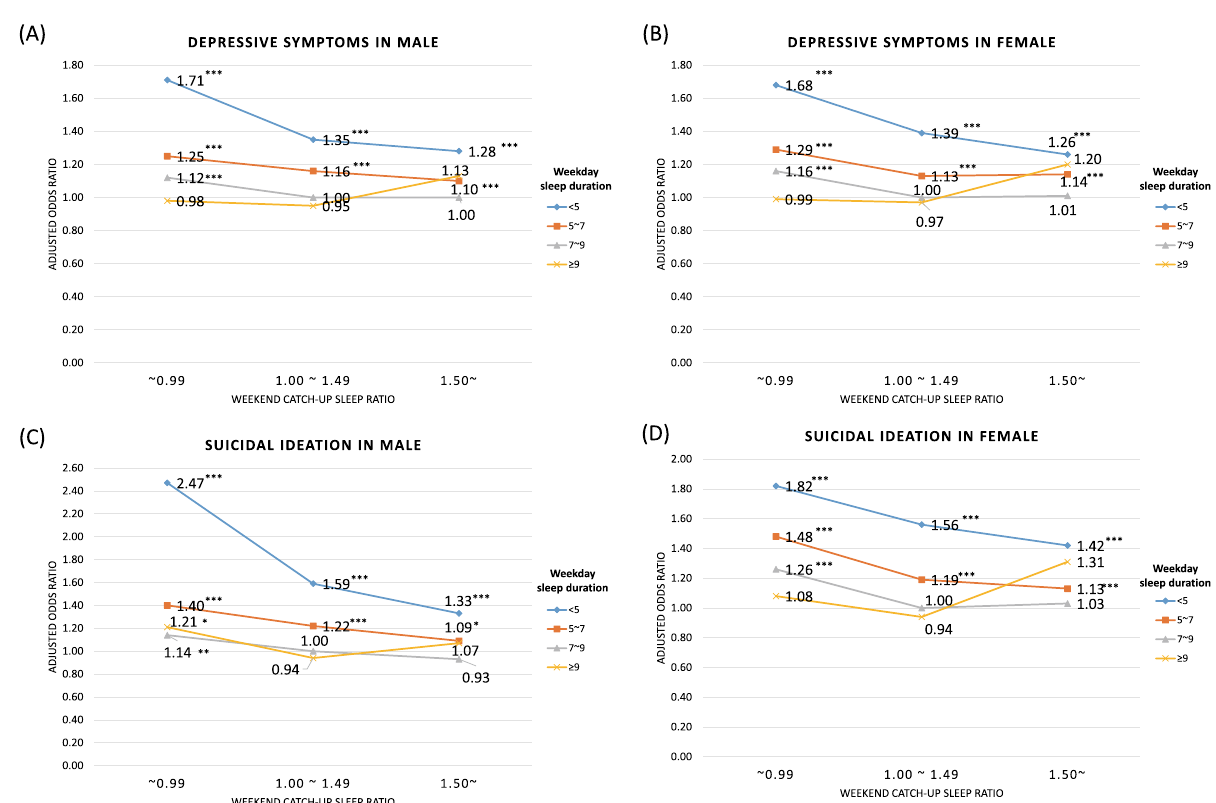
Figure 1. Results of the multiple logistic regression analysis, including interaction between weekend CUS ratio and weekday sleep duration. * P value < 0.05; ** < 0.01; *** < 0.001. CUS catch-up